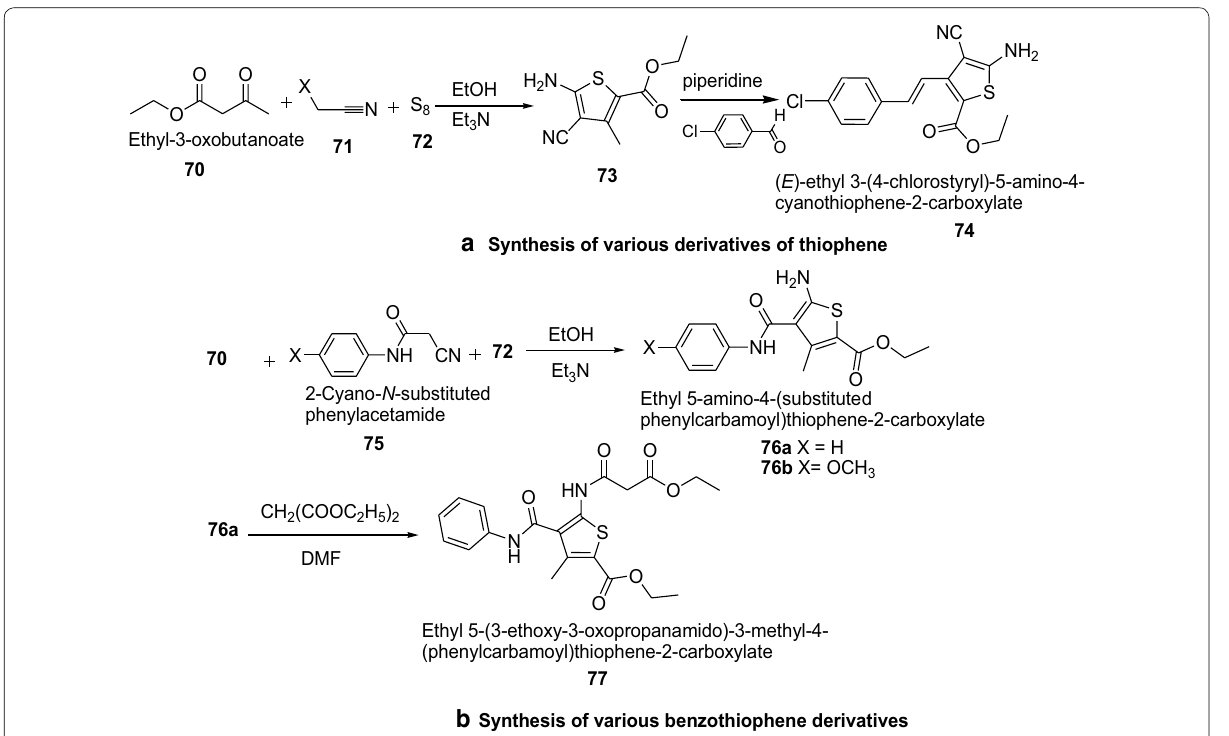
However, all the synthesized compounds showed consid- erable anticancer activity as compared to cyclophospha- mide. The results of synthesized compounds presented in Table 14. Mohareb et al. [30] developed a convenient synthetic approach for novel thiophene and benzothiophene deriv- atives (Scheme 14). The in vitro cytotoxicity was screened